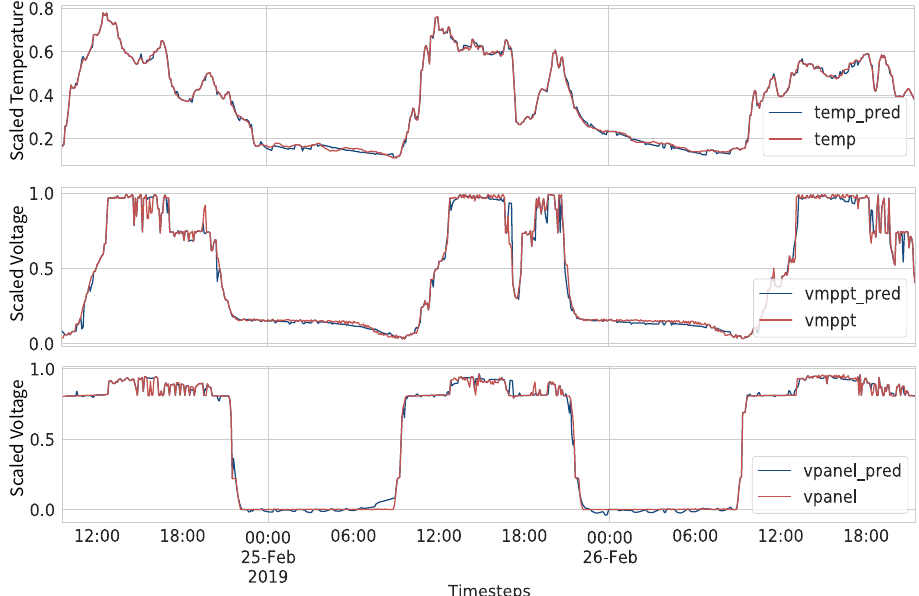
Figure 20. Comparison of real and all predicted time series saving 60% of